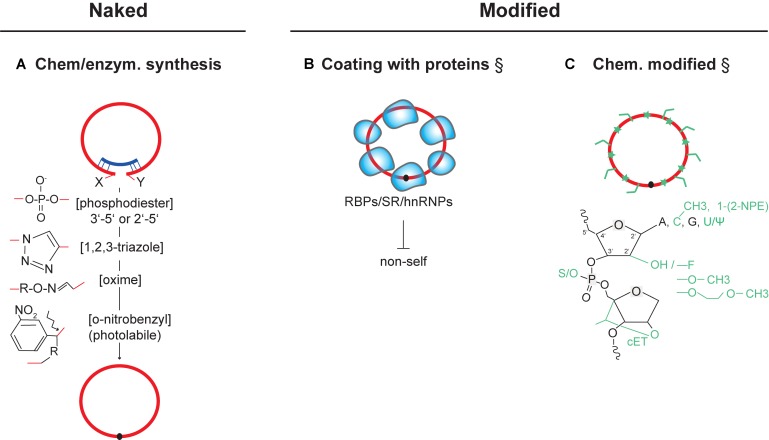
Delivery of in vitro circularized circRNAs for therapeutic use. Strategies that have experimentally not yet been achieved are marked (§). (A) Chemical structures of key cis-reactive chemical moieties mediating chemical or enzymatic circularization (by RNA ligases or ribozymes). As one example, introducing photolabile linkers into the backbone of circular RNAs can be employed to acutely inactivate circRNAs through linearization (Richards et al., 2010; Griepenburg et al., 2013; Wu et al., 2013) (bottom). (B) Strategy for coating synthetically produced circRNAs with RNA-binding proteins and splicing factors. Coating could be used to avoid recognition as non-self and inhibit innate-immune activation after transfection. (C) Possible chemical modification of synthetic circRNAs at RNA bases, 2′ position in the ribose, and in the phosphodiester backbone. Modifications can have effects on improving stability, binding affinity, and pharmacokinetics (see text). ψ (Pseudouridine), cET (2′,4′-constrained ethyl), 1-[2-NPE] (1-[2-nitrophenyl]ethyl). NPE-like modifications of the RNA nucleobases, or other photolabile cages in RNA, can be conditionally cleaved-off by light, allowing acute conversion to an active state (Schafer et al., 2013). RNA (red), antisense oligos (dark blue), RNA-binding proteins (light blue shapes).